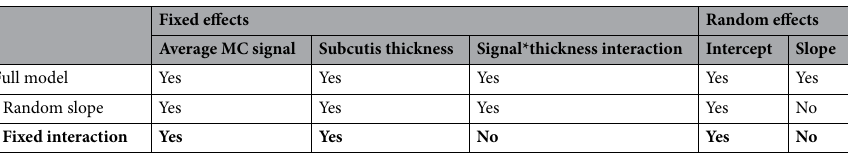
Table 1. Model components for three versions of a linear mixed model. The chosen model is outlined in